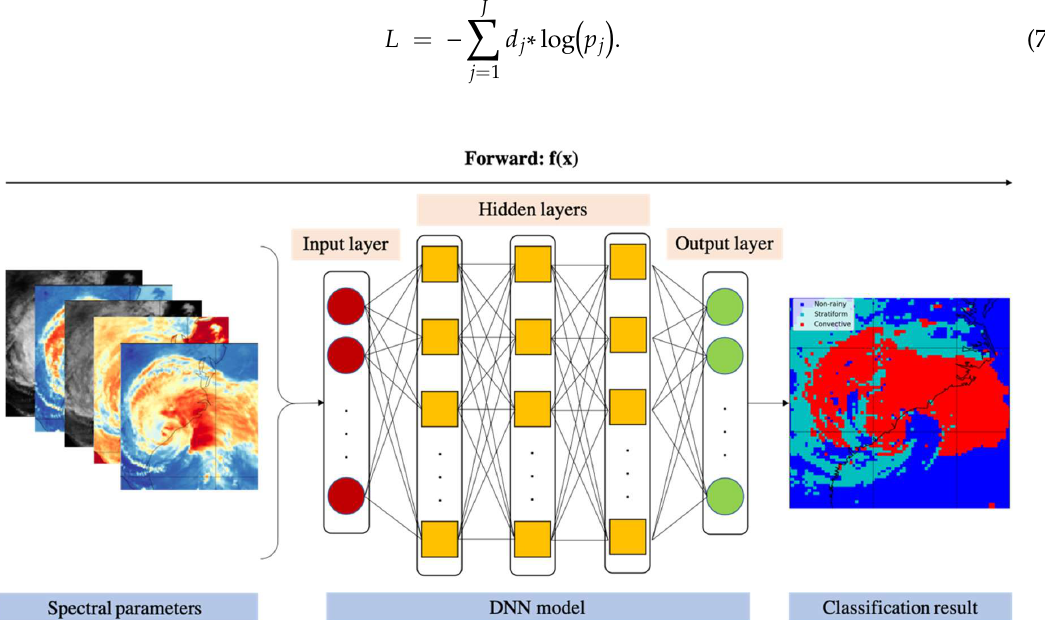
Figure 3. Flowchart of the deep neural network (DNN) model for cloud classification and delineation. The back-propagation (BP) algorithm [56] is adopted to update the weights and bias of DNN based on the calculated loss.